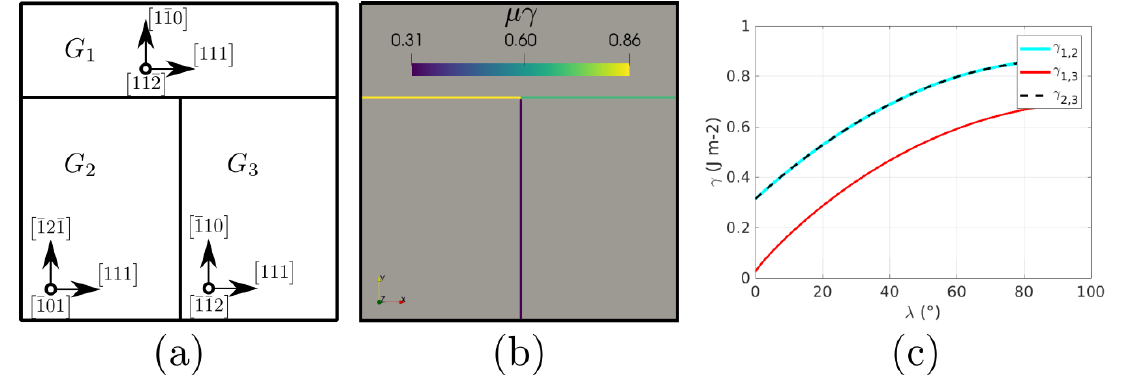
Figure 20. ( a ) Grain orientations, ( b ) initial reduced mobility [mm 2 /s], ( c ) change of GB energy as a function of the GB inclination, λ , with respect to the x-axis, evaluated using the code GB5DOF